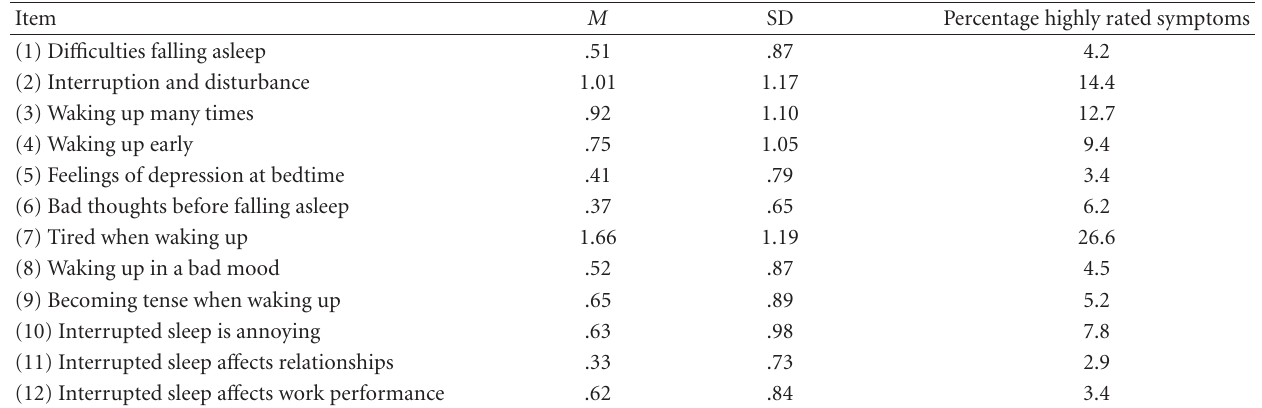
Table 2: Prevalence of insomnia symptoms among psychotherapists.